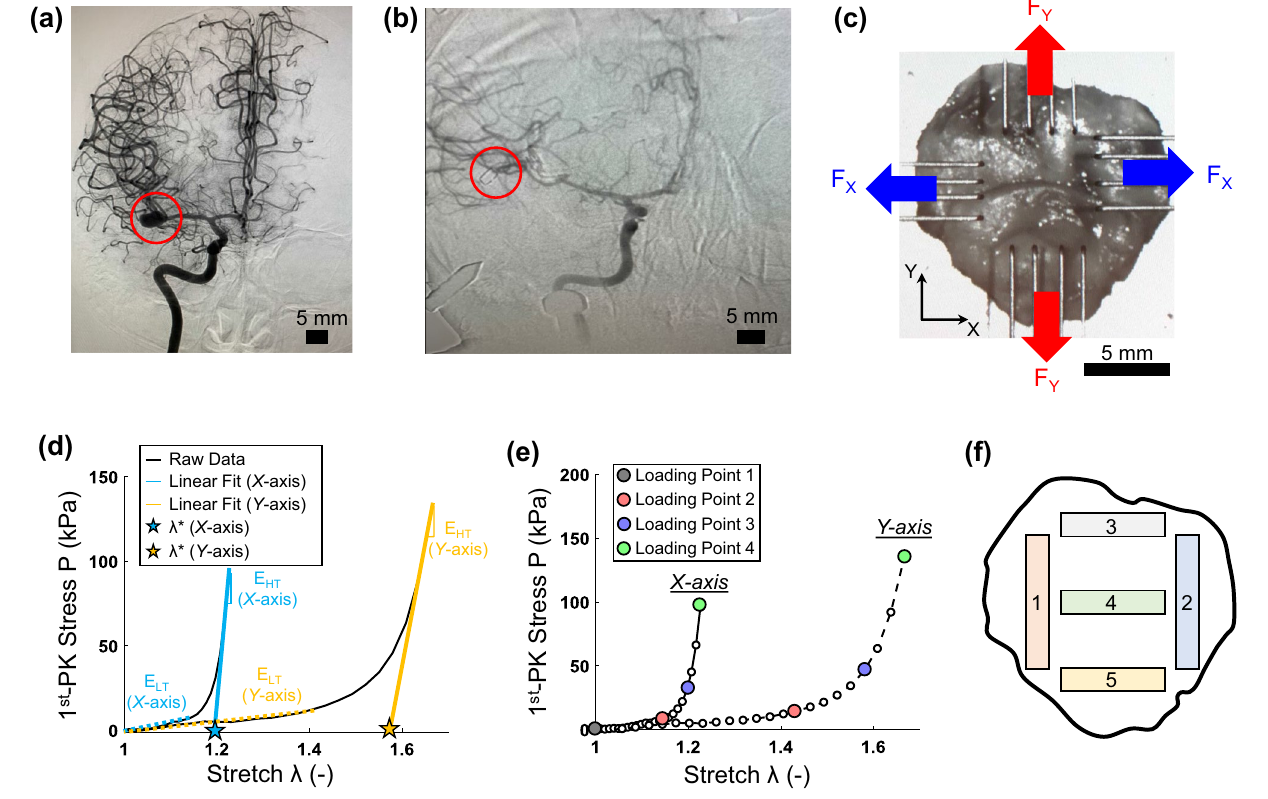
Figure 1. ( a ) Intraoperative angiogram showing the patient’s aneurysm prior to surgical clipping and ( b ) after operation. ( c ) Resected aneurysm tissue mounted to the CellScale BioTester. ( d ) Linear fits for the low-tensile modulus ( E LT ) and high-tensile modulus ( E HT ) of Protocol 1 ( F X : F Y = 1 : 1 ). Linear fits of the high-tensile ∗ modulus were used to determine (cid:31) . ( e ) Definition of four loading points for the load-dependent pSFDI analysis Loading Point 1—unloaded; Loading Point 2—prior to the modulus transition; Loading Point 3—after the modulus transition; Loading Point 4—peak loading). ( f ) Location of the five tissue strips used for histological